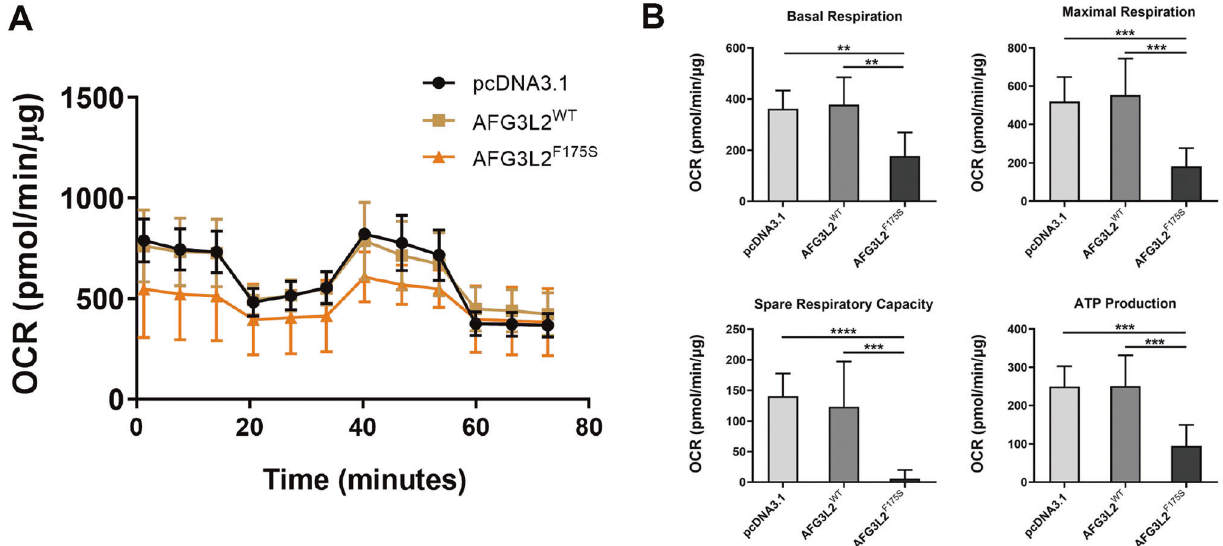
Fig. 4 F175S mutation affected the mitochondrial function. A Average seahorse pro fi les demonstrating oxygen consumption rate (OCR). B Representative bar graphs demonstrating basal respiration, maximal respiration, spare respiratory capacity and ATP production. (Values expressed as mean ± SD, pcDNA3.1: n = 7, AFG3L2 WT : n = 5, AFG3L2 F175S : n = 5, ** p < 0.01, *** p < 0.001, **** p <